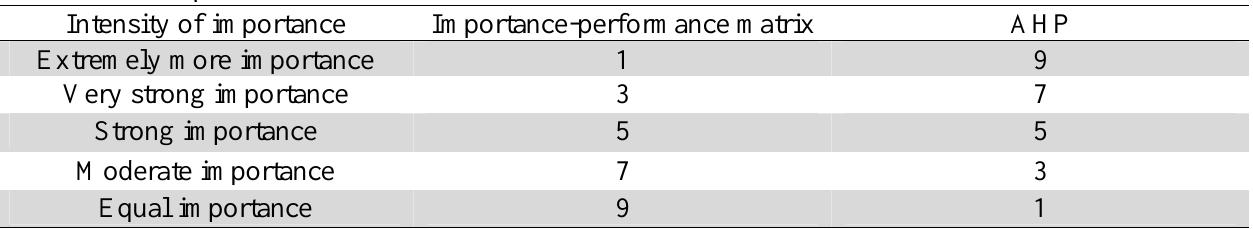
Priorities of Importance-Performance Matrix versus